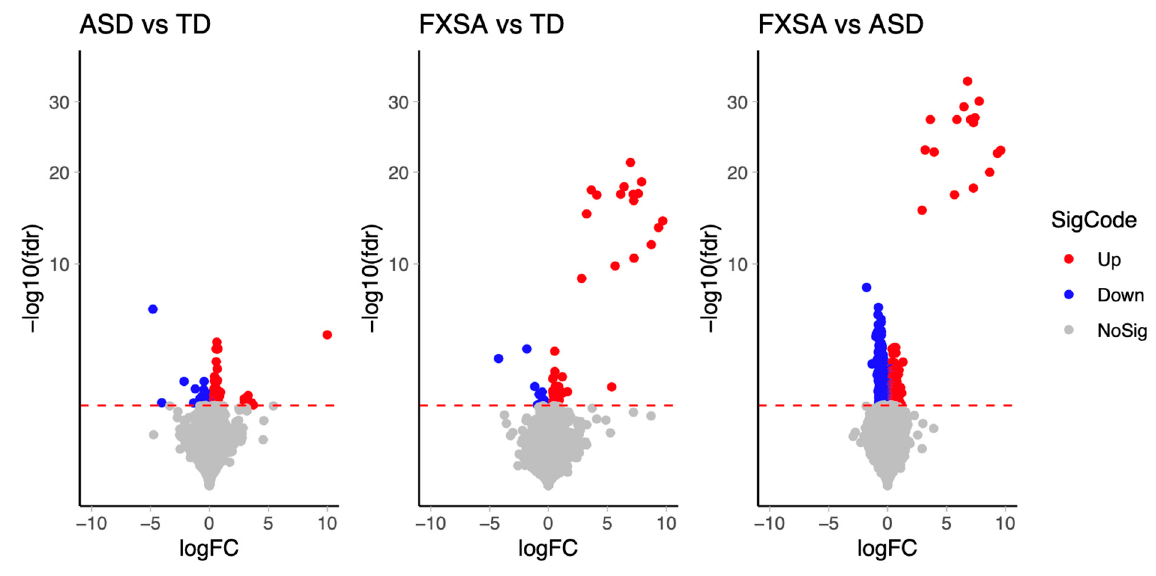
Figure 1. Volcano plot of DMS. Volcano plots for the significant DMS that were identified with adjusted p -value < 0.05 in the three groups comparison, ASD vs. TD, FXSA vs. TD and FXSA vs. ASD, where blue circles indicate significant hypomethylation probes with adj p -value < 0.05 and red circles indicate hypermethylation probes with adj p -value < 0.05.